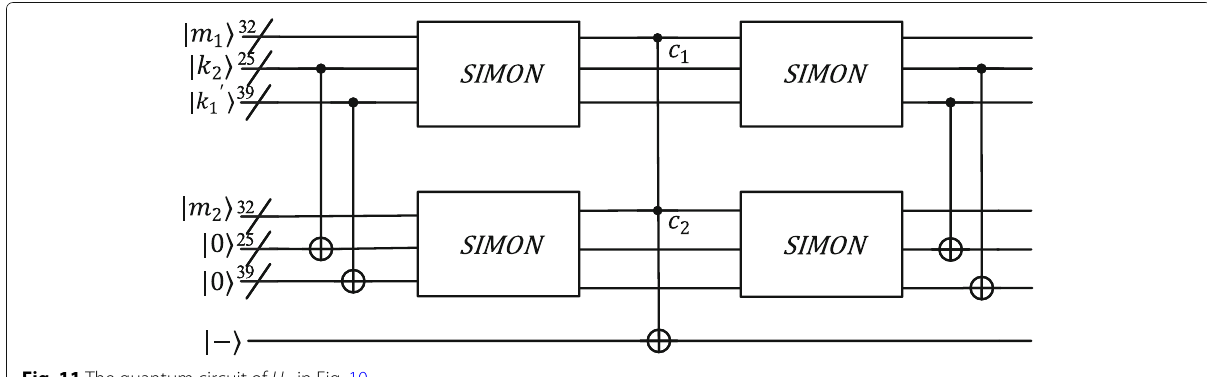
Fig. 11 The quantum circuit of U g in Fig. 10